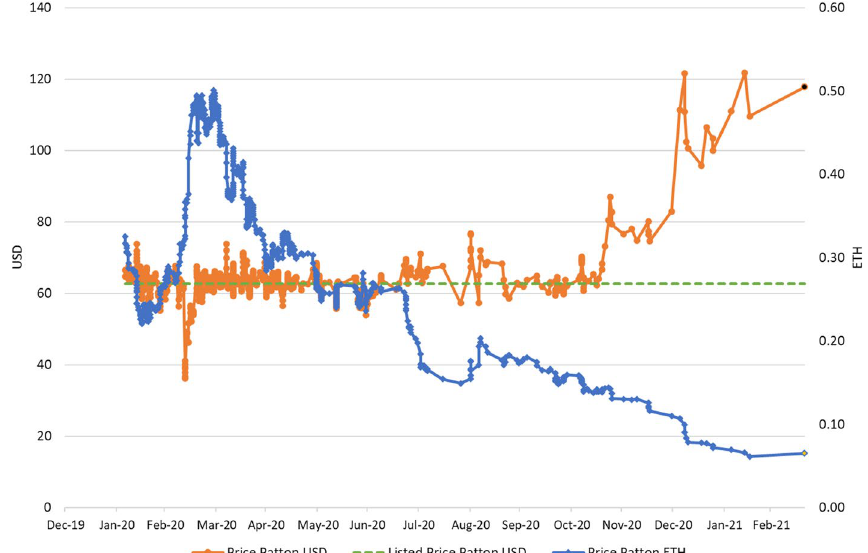
Fig. 13 Price (in USD and ETH) of 9336 Patton Street Detroit MI. Each dot represents one transaction. Last colored dot is ask price on